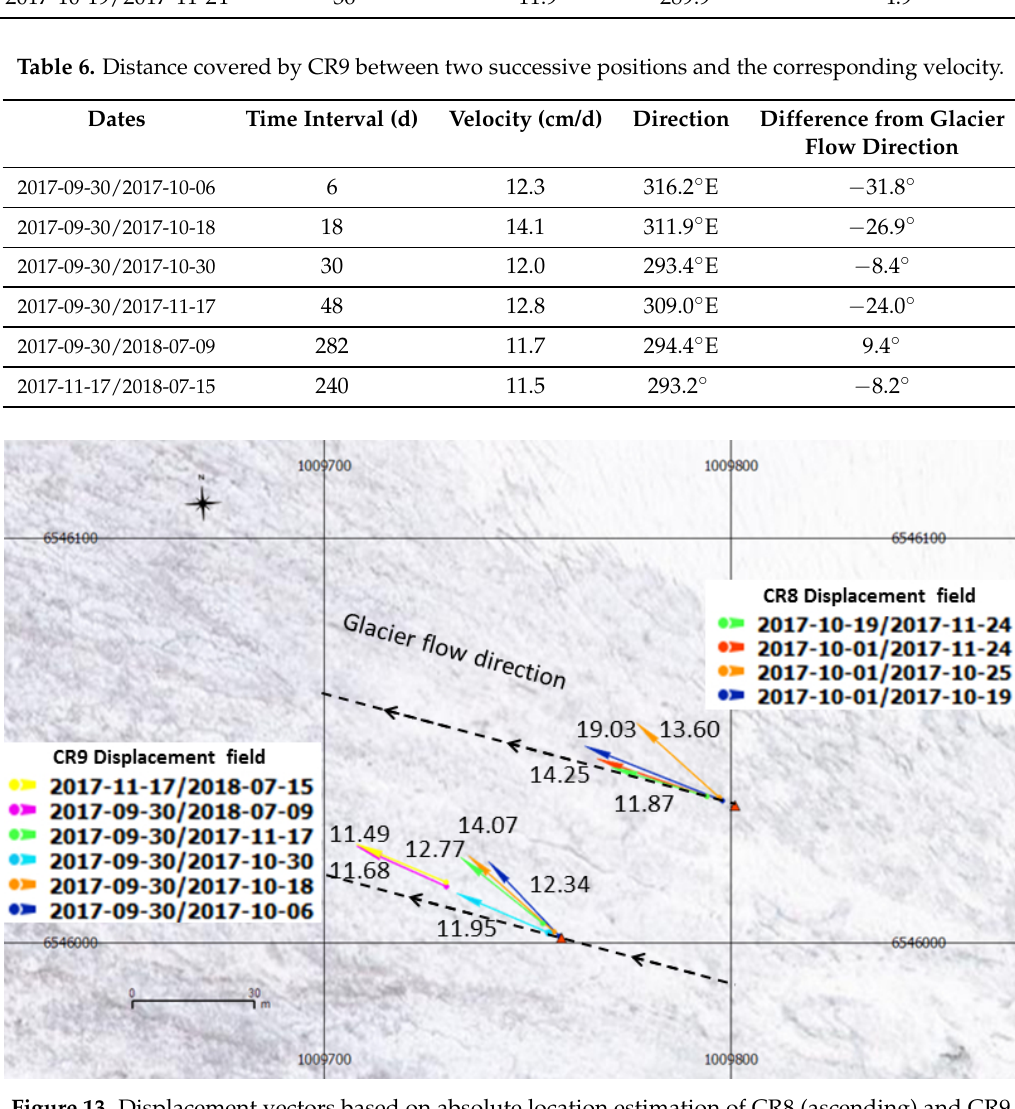
Figure 13. Displacement vectors based on absolute location estimation of CR8 (ascending) and CR9 (descending). Color arrows indicate the orientation and the magnitude of the displacement (rates are indicated in black (cm/day)). The origin of the color arrows indicate the position of the CR at the end of each analyzed time intervals (4 for CR8, 6 for CR9). The glacier flow direction, i.e., the main slope direction, is indicated by black dashed arrows. Background image source: